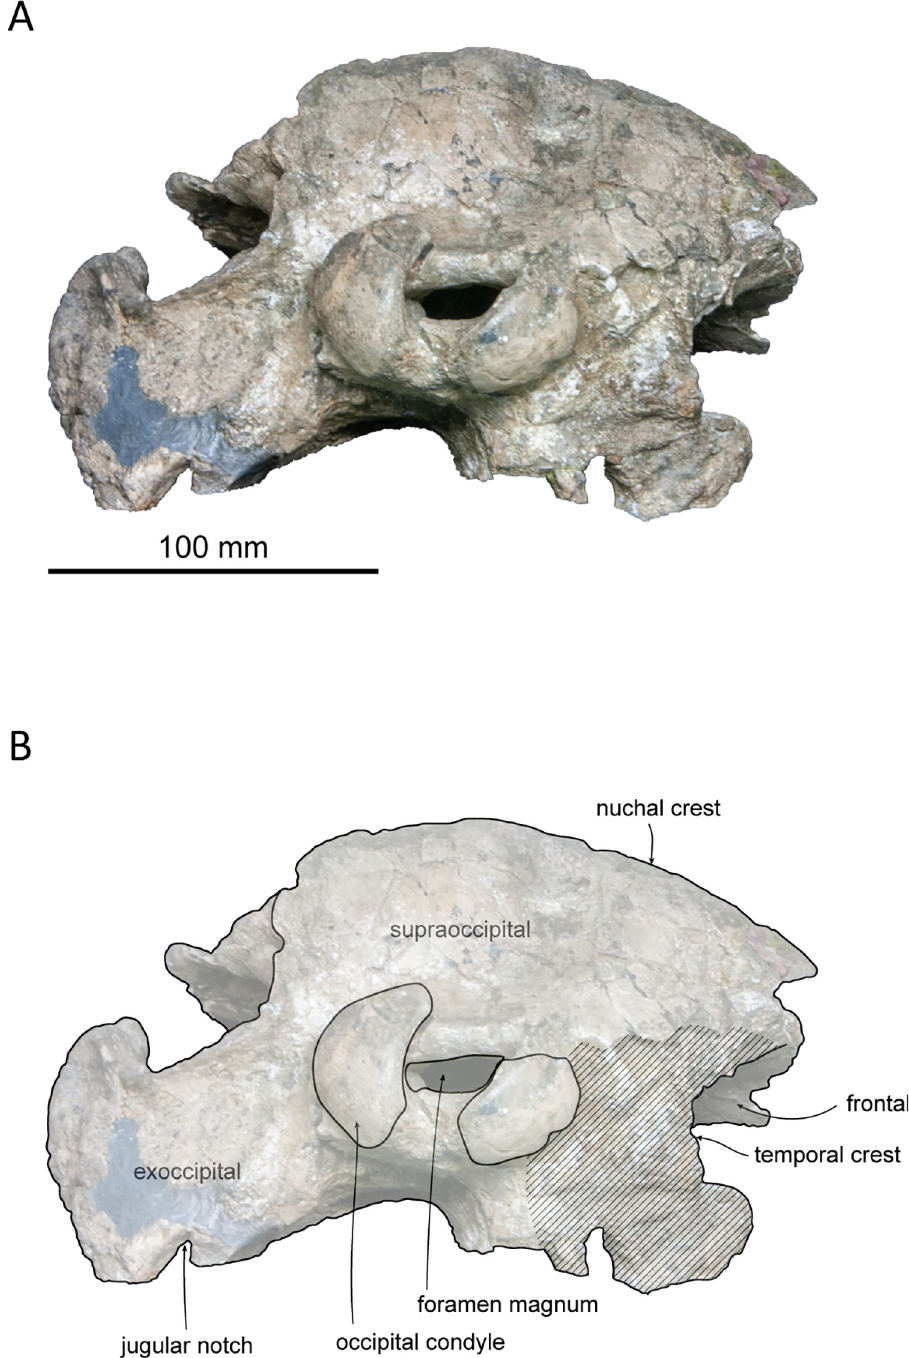
Fig 5. Posterior view of the skull of Platysvercus ugonis gen. et sp. nov., holotype, UTHFM 00034. (A) photo. (B) corresponding line drawing with anatomical interpretations. Scale bar equals 100